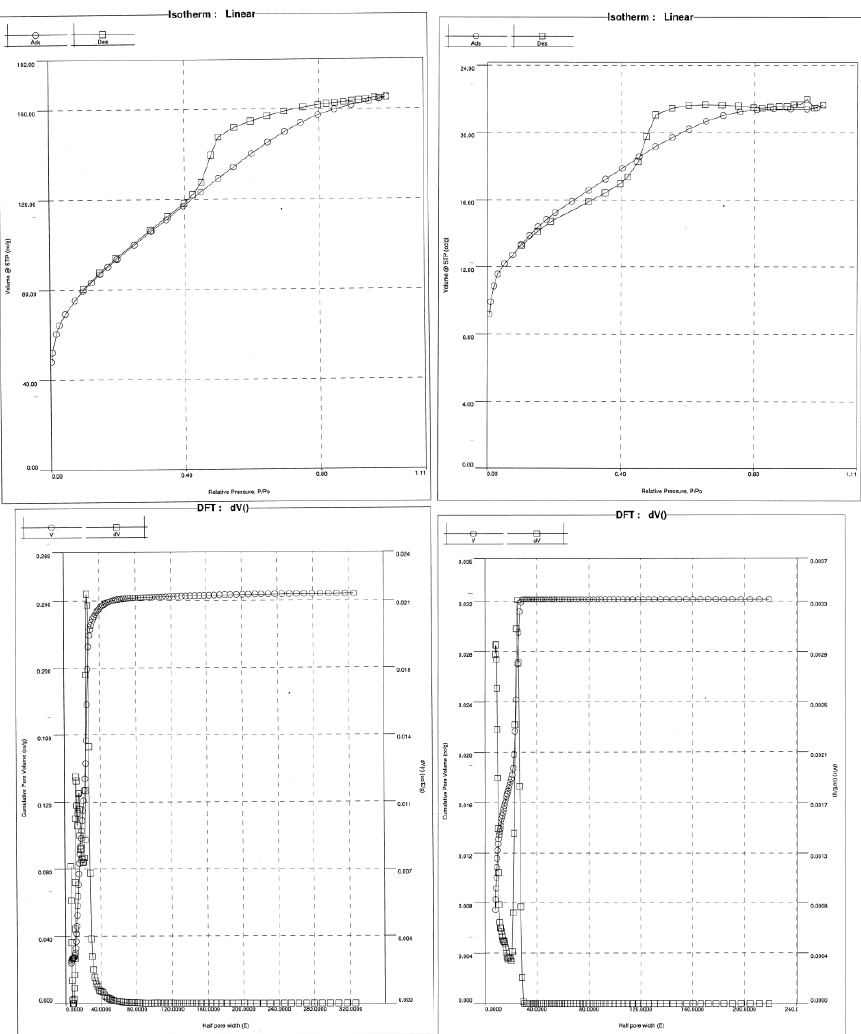
Figure 6. Nitrogen adsorption-desorption isotherms and the functions of pore volume distribution by the pore radius for sample 7 TiSi-powder fraction and sample 7 carbon-TiSi fraction: Top left, lower left, isotherms and distribution accordingly to TiSi-powder fraction sample; top right, lower right, isotherms and distribution accordingly to carbon-TiSi fraction sample. For sample’s 7 TiSi-powder fraction V S = 0.25 cm 3 /g, S sp. = 326 m 2 /g. For sample’s 7 carbon-TiSi fraction V S = 0.033 cm 3 /g, S sp. = 53 m 2 /g.